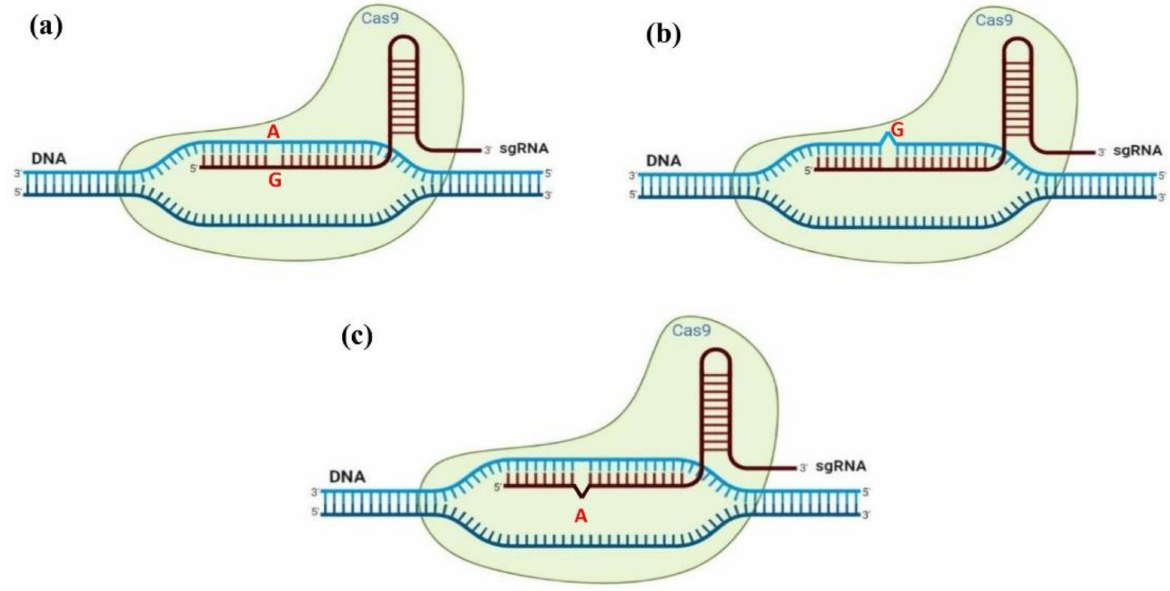
Figure 8. Three types of off-targets induced by CRISPR-mediated genome editing; ( a ) off-target sites with base mismatch, ( b ) off-target sites with extra base (DNA bulge or deletion), and ( c ) off-target site with missing base (RNA bulge or